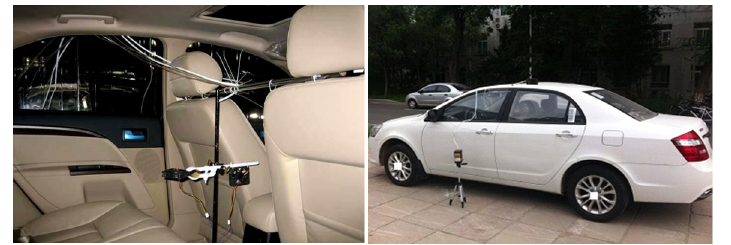
Fig 3. Photo of the experimental